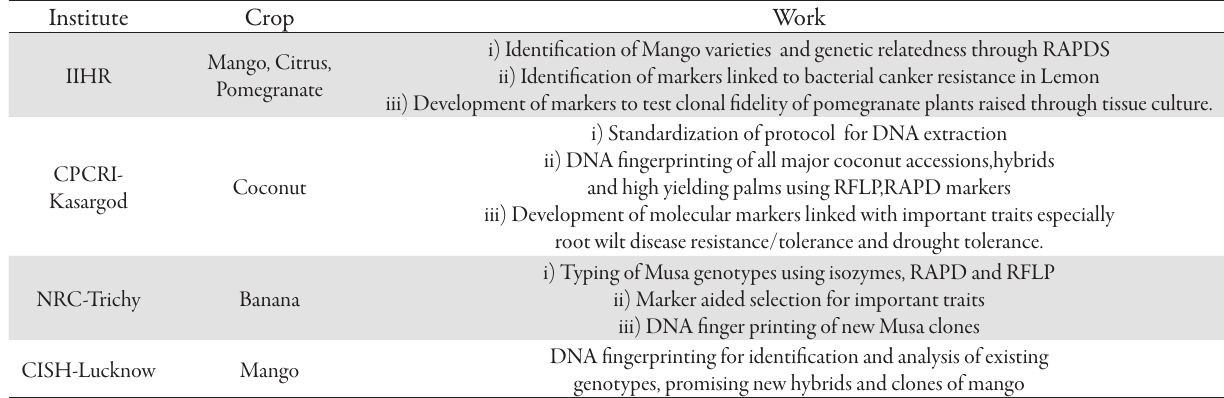
Tab. 4. Supporting institutes on DNA